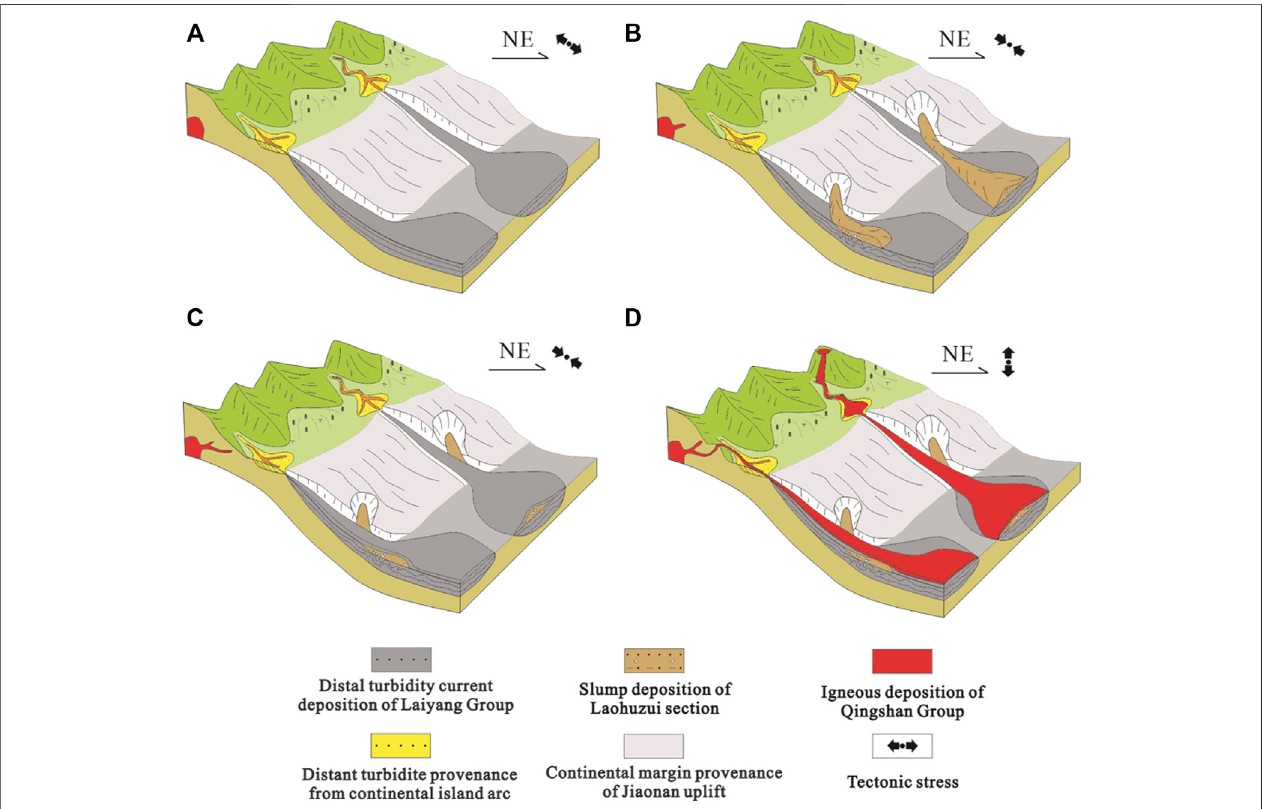
FIGURE 13 | The sedimentary model of the Laohuzui section in the Lingshan Island area. (A) Interbedded siltstone deposits at the end of the Laiyang Group. (B) Tectonic inversion developed, causing slump deposits to develop near the junction of the Laiyang Group and Qingshan Group. (C) During the short calm period, the Laohuzui section continued to accept the mixture provenance from a continental margin and form distal turbidity current deposits. (D) Tectonic extension period, when the Qingshan Group accepted the igneous rock deposits.